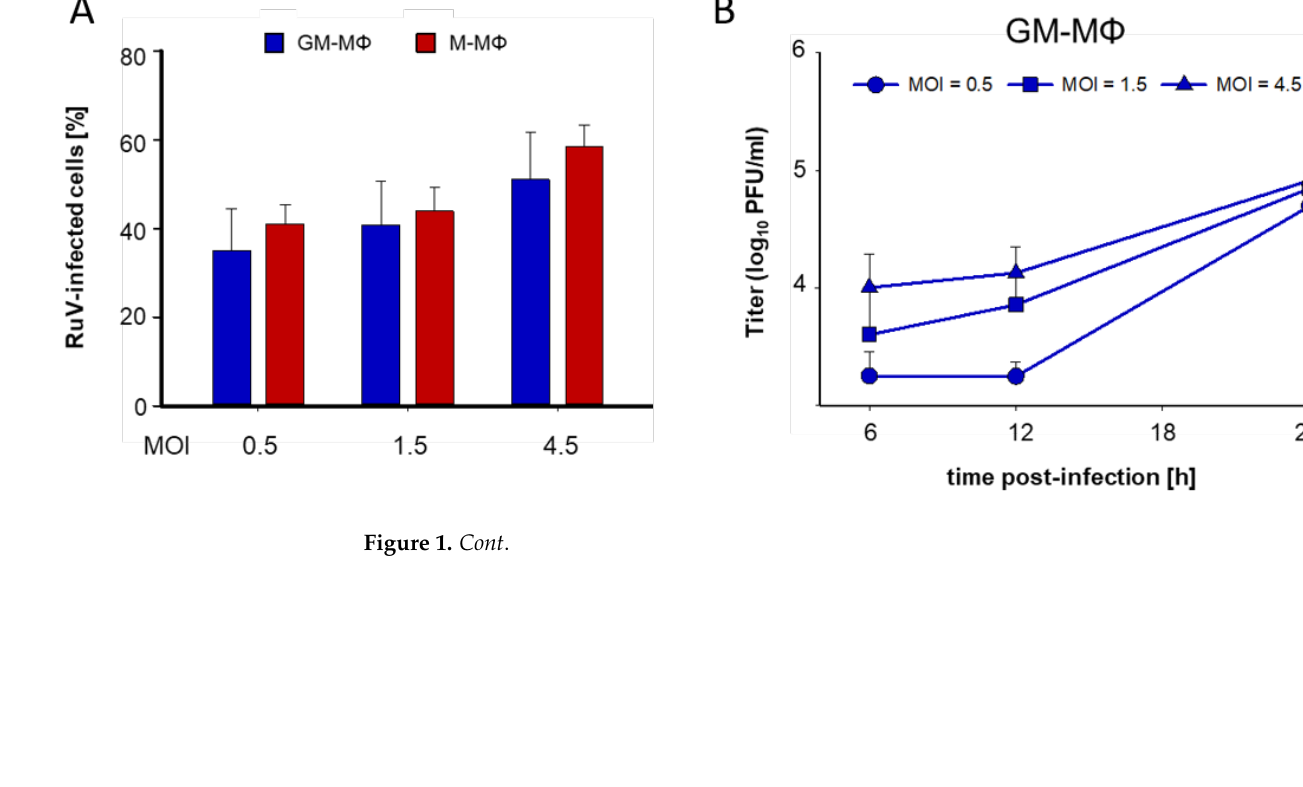
Figure 1. A higher initial infectious dose in GM- and M- MΦs influences ea rly release of extracellular virus particles and apoptosis induction. After infection of GM- and M- MΦ with three different MOIs the course of infection was analysed. ( A ) The number of RuV-positive cells was determined at 24 hpi through immunofluorescence analysis with anti-capsid antibodies. ( B ) and ( C ) The number of extracellular virus particles was determined by standard plaque assay. ( D ) Apoptotic cells were counted on a fluorescent microscope as cells with CellEvent Caspase 3/7 green reagent-positive nu- clei in reference to the total cell number. ( A ) and ( D ) Two random fields per microscope slide were counted ( n = 3, biological replicates). Total cell number was determined through a DNA intercalat- ing dye. 2.11. Statistical Analysis Data are shown as the mean ± standard deviation (SD). All statistical analyses were carried out using the SigmaPlot ® software. Statistical significance was calculated with Stu- dent’s t -test or ANOVA test. 3. Results 3.1. The Initial Infectious Dose Has a Slight Influence on RuV Infection in GM- and M- MΦ In our previous study, we examined the response of MΦ to RuV through the appli- cation of just one infectious dose. However, susceptibility of a given cell line can be influ- enced by variations in the applied infectious dose. Especially under conditions of high cellular susceptibility, a low viral load is sufficient to initiate an efficient infectious cycle. Thus, we included a slightly higher and lower MOI in addition to the previously pub- lished MOI of 1.5 [8], namely an MOI of 0.5, 1.5, and 4.5. Figure 1A shows that the number of infected cells as determined by immunofluorescence analysis with anti-capsid antibod- ies was increasing on both MΦ types with a higher MOI. Hereafter, the time -dependent release of extracellular virus particles was studied under these three different MOIs. Ex- cept for 12 h post-infection (hpi) on GM- MΦ, similar amoun ts of virus particles were pre- sent after infection with different MOIs (Figure 1B). This could reflect a faster uptake rate